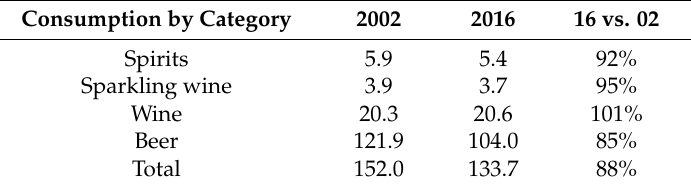
Table 2. Average per capita consumption alcoholic drinks in Germany (2002 vs. 2016)